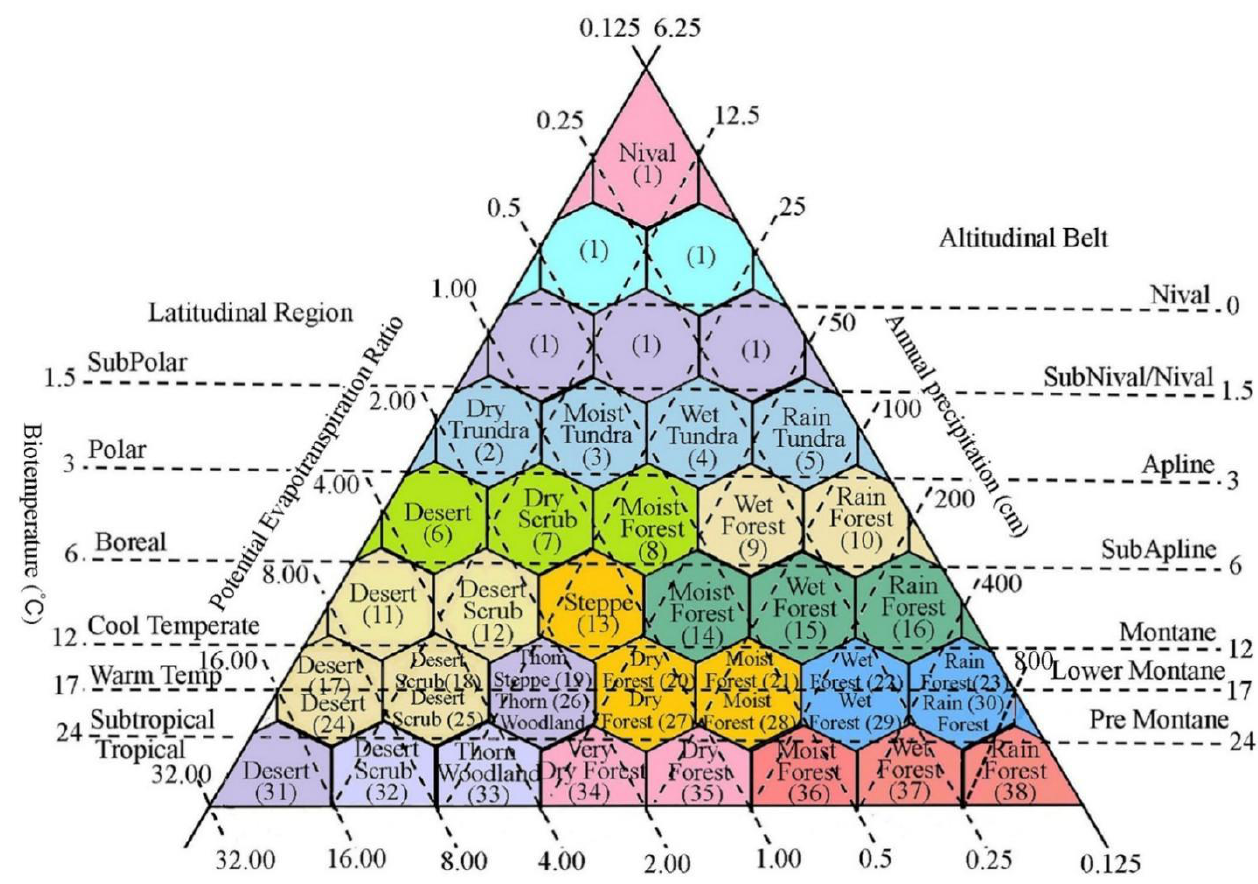
Figure 5. The Holdridge Life Zone Model [70] .